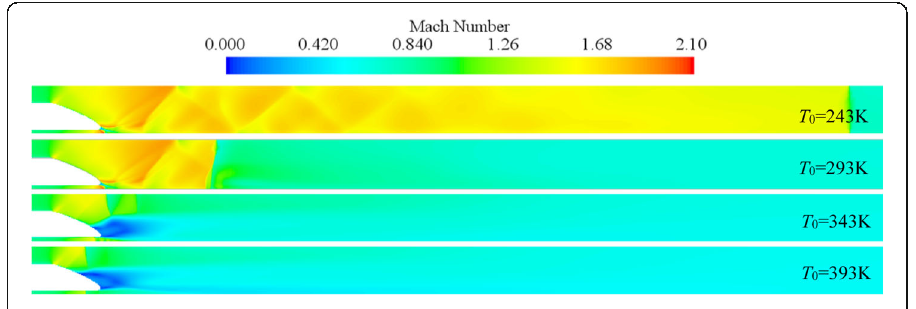
Fig. 17 The contours of Mach number in the wake area at different T